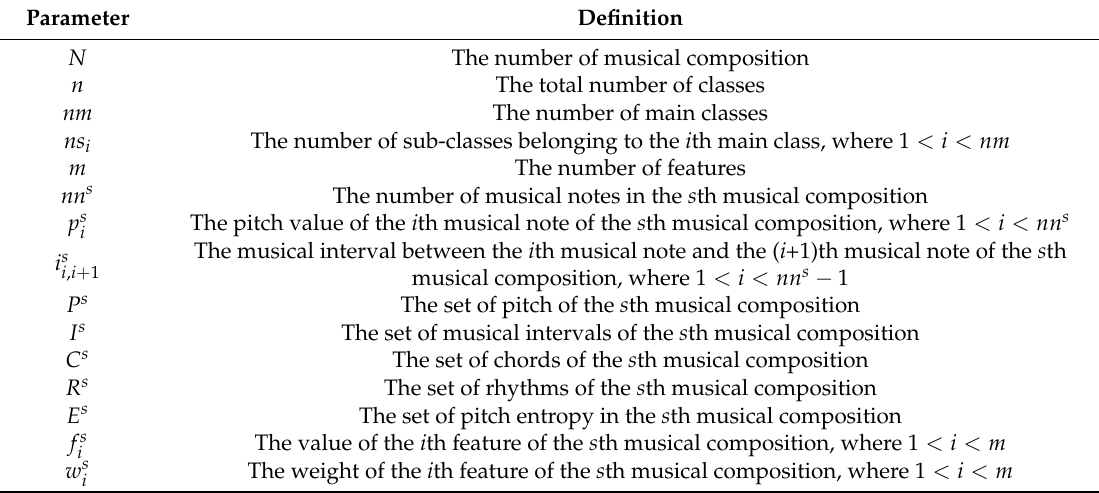
Table 1. The definition of